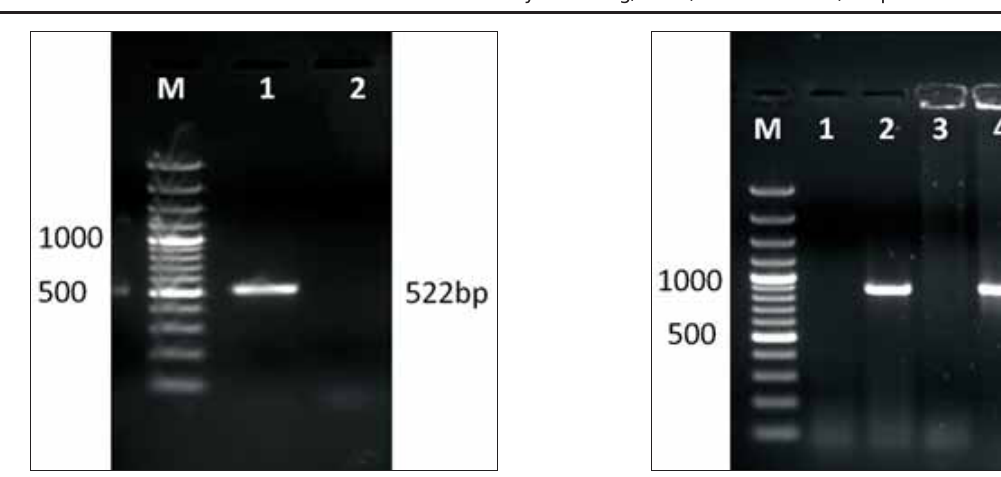
Figure-3: DNA electrophoresis of polymerase chain reaction amplicons of recombinant clones; M-DNA Ladder,